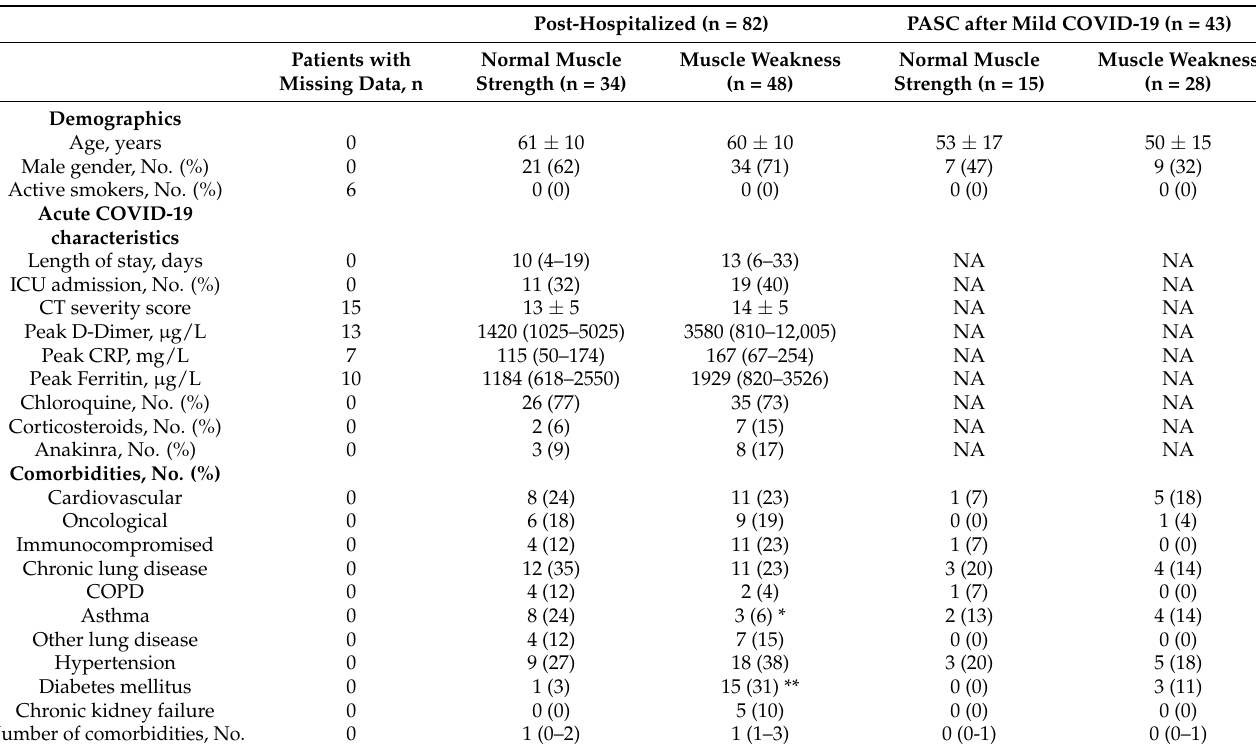
Table 1. Demographics, acute COVID-19 characteristics and comorbidities of post-hospitalized and PASC after mild COVID-19 patients stratified by muscle weakness. Post-Hospitalized (n = 82) PASC after Mild COVID-19 (n = 43) Patients with Normal Muscle Muscle Weakness Missing Data, n Strength (n = 34) (n = 48)